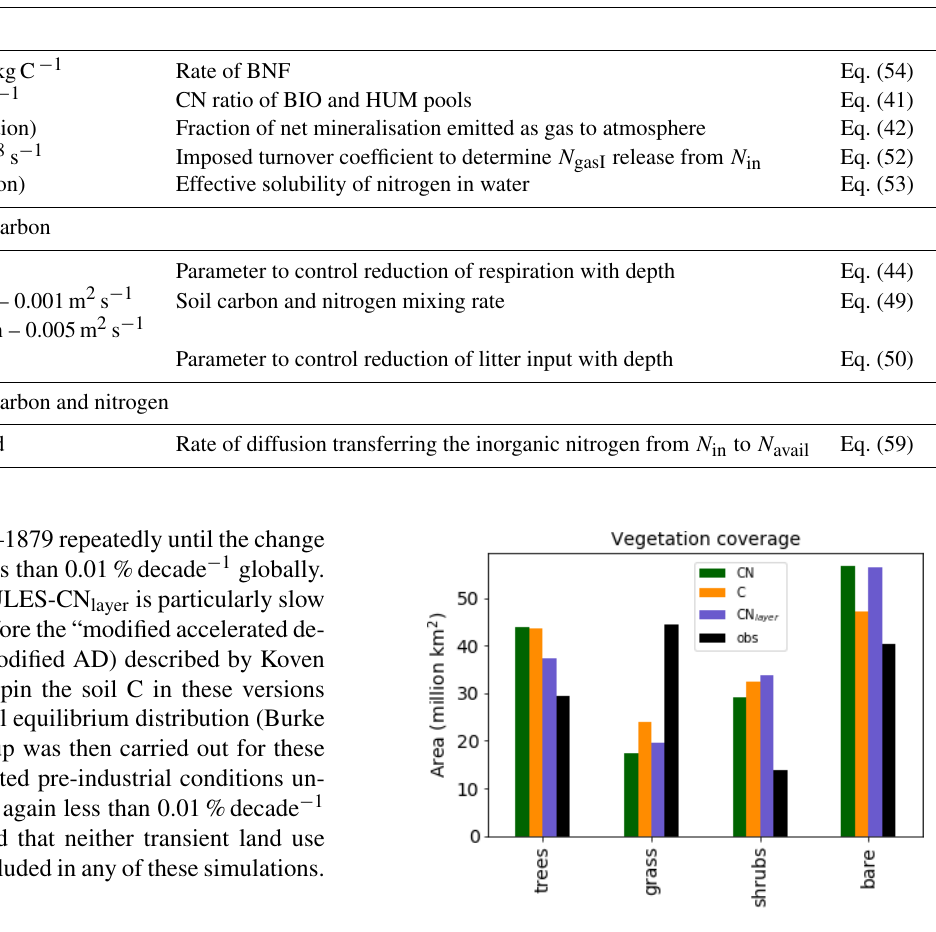
Figure 3. Total area covered by each vegetation type for the three different JULES configurations. The observations are derived from the European Space Agency (ESA) Climate Change Initiative (CCI) Land Cover data for 2010 Poulter et al. (2015) converted to JULES PFTs by Hartley et al.